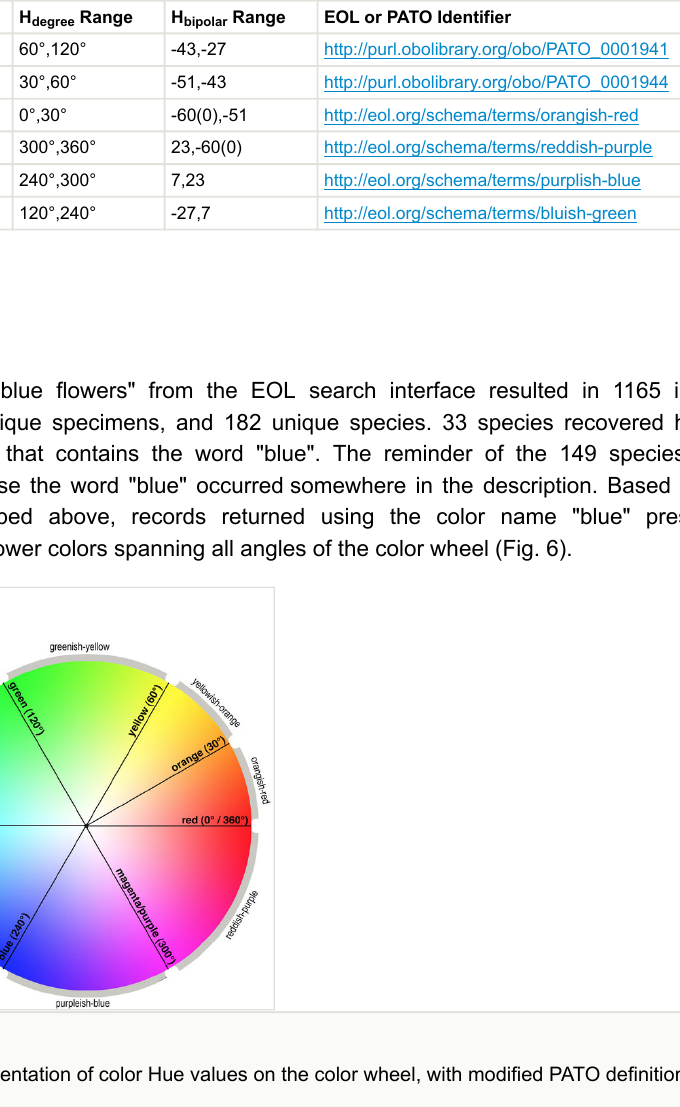
Fig. 7 graphically represents the results on the bipolar linear scale. Each point on the scatterplot indicates the hue value H of one of the sampled images, with the Y-axis bipolar being the hue value and the X-axis the unique image number. The colored lines running horizontally across the scatterplot represent the position of pure hues of green, cyan, blue, magenta, and red drawn at their respective values. To the right, the histogram shows the